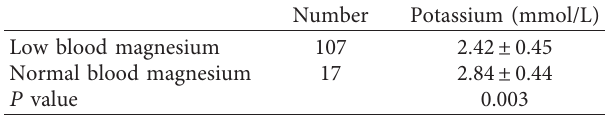
Table 5: Comparison of serum potassium levels between the low blood magnesium and normal blood magnesium groups ( x ± s